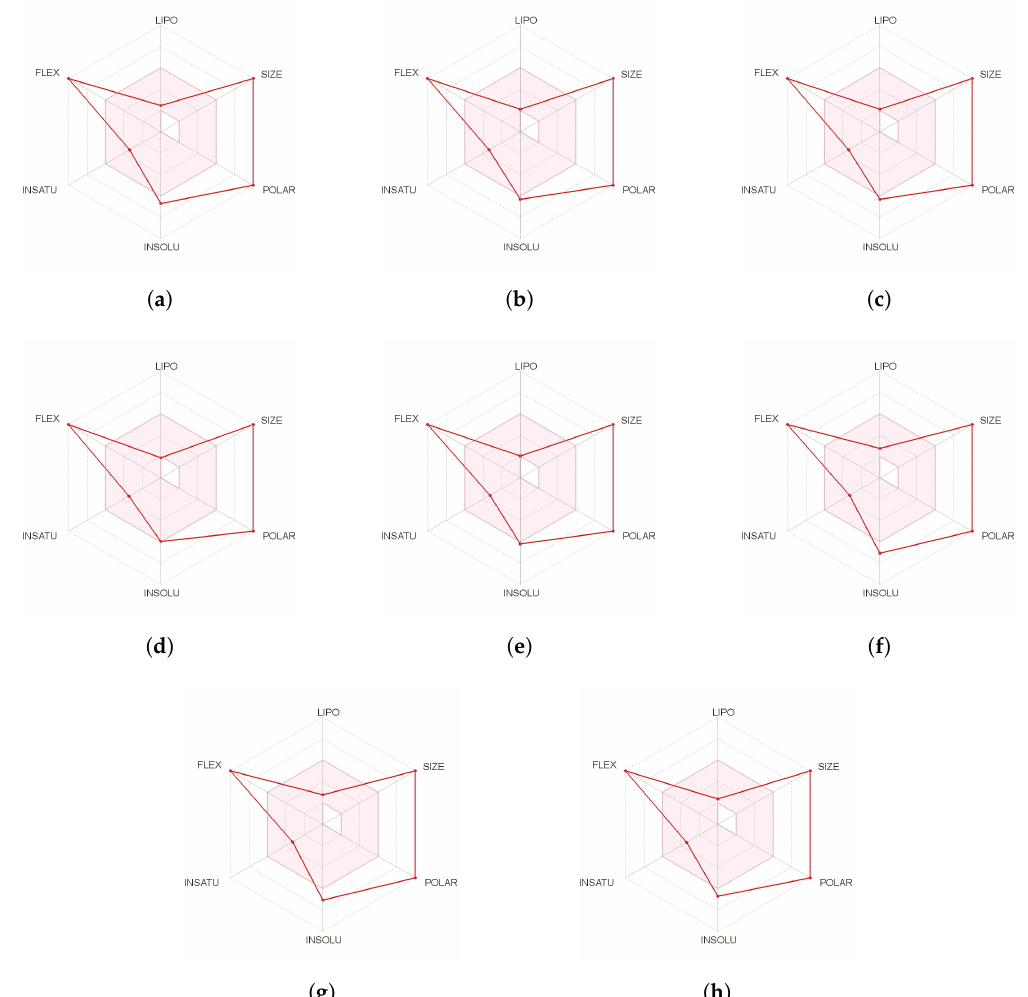
Figure 2. Bioavailability radars of the ( a ) Discodermin A, ( b ) Discodermin B, ( c ) Discodermin C, ( d ) Discodermin D, ( e ) Discodermin E, ( f ) Discodermin F, ( g ) Discodermin G and ( h ) Discodermin H